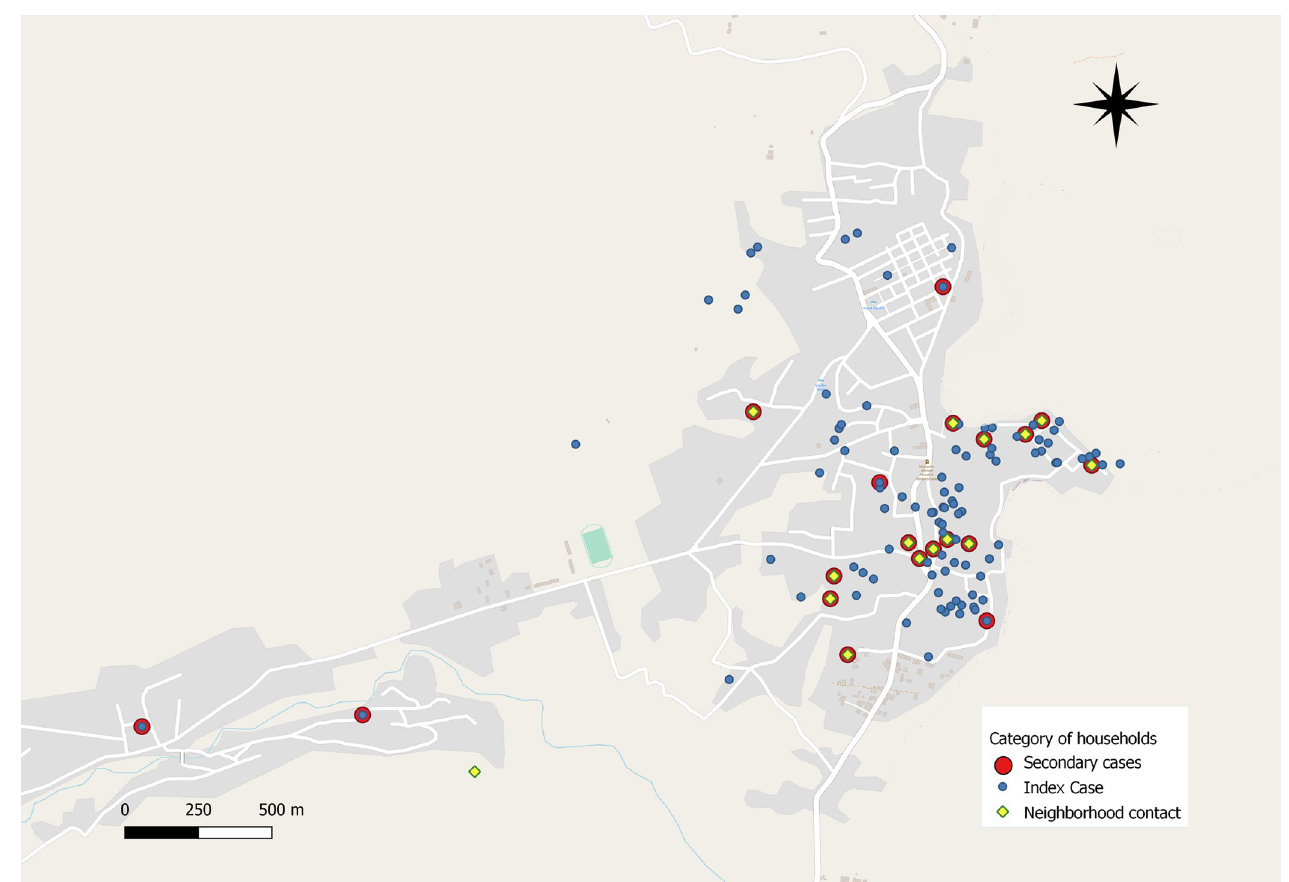
Fig 2. Map of a village with the households screened for leprosy (a random error of 25 meters was added to protect privacy of households screened). We used OpenStreetMap as a base layer for this map (https://www.openstreetmap.org/#map=8/50.510/4.475).